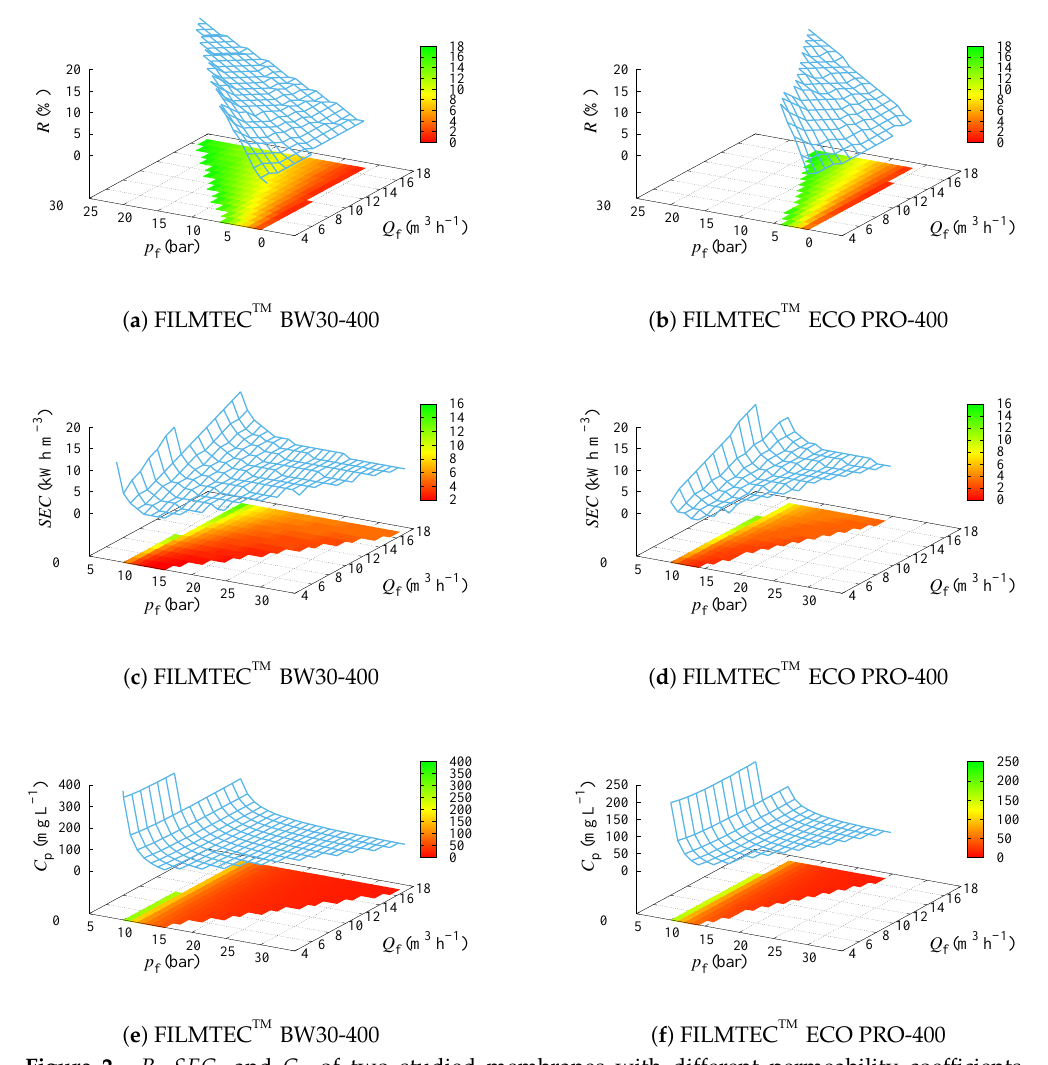
Figure 2. R , SEC , and C p of two studied membranes with different permeability coefficients, C f = 5 g L − 1 , L / d = 6 and β = 90 ◦ . ( a , c , e ) FILMTEC TM BW30-400; ( b , d , f ) FILMTEC TM ECO PRO-400. Figures 3 and 4 show the exponential growth of SEC with the increase of C f . As C f increases. there is a slight increase in the separation of the exponential curves of each feed spacer geometry. This reveals that the effect of the feed spacer geometry on SEC in seawater desalination is more pronounced than in brackish water. The SEC was lower for the membrane with the higher coefficient A , but the separation between curves was higher for the ECO PRO membrane than for the BW30-400. This shows that the impact of the feed spacer geometry with the C f was higher for the FILMTEC TM ECO PRO-400